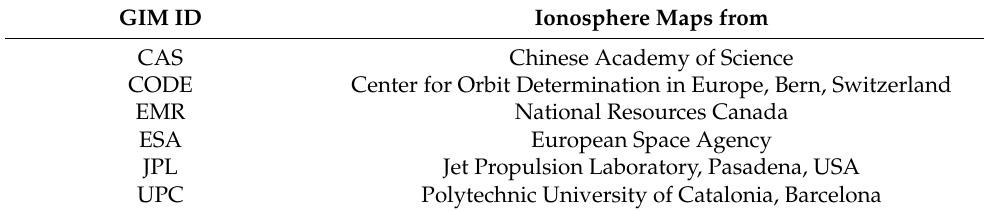
Table 4. Global ionosphere maps used in the analysis. GIM ID